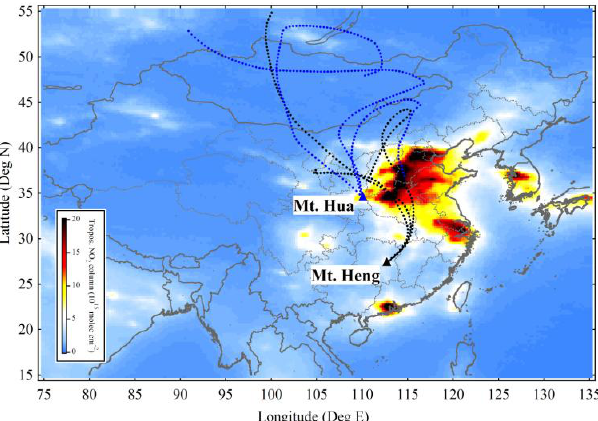
Fig. 3. Three-day backward trajectories for the dust event at Mt. Hua and Mt. Heng. Fig. 3. The 72-h backward trajectories for the dust event at Mt. Hua The NO column data from GOME and SCIAMMACHY (averaged over 1996-2007, and Mt. Heng. The NO 2 column data from GOME and SCIA- 2 MACHY (averaged over 1996–2007, Wang et al., 2009) are shown Wang et al., 2009) are shown in the shaded areas. in the shaded